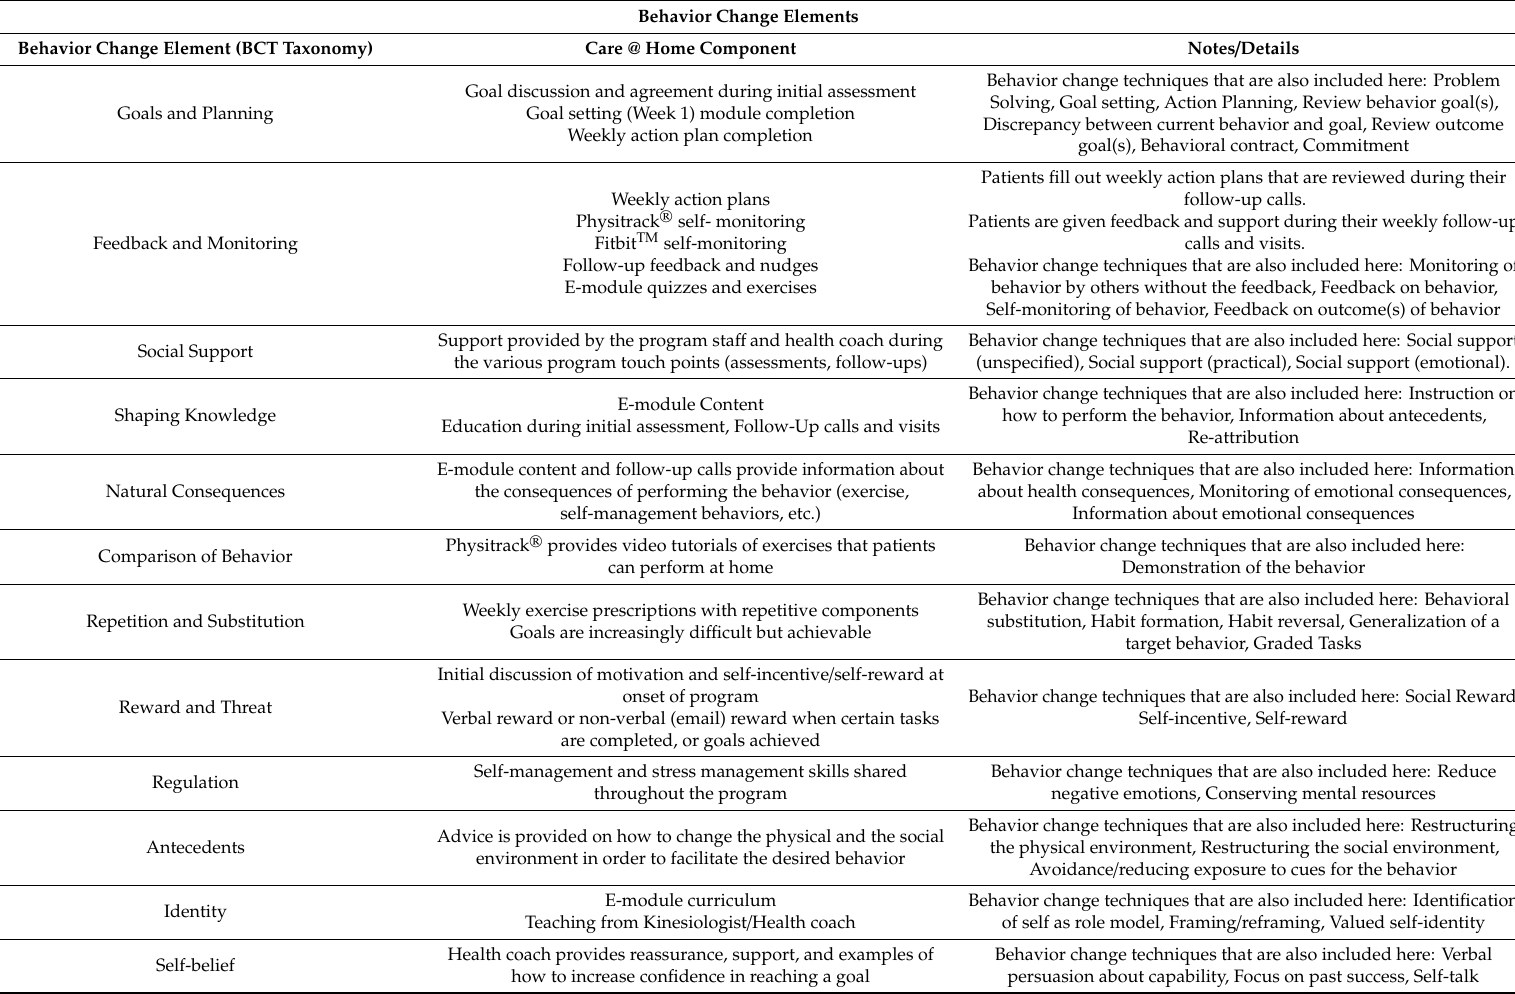
Table 1. Behavior Change elements and tools for CaRE @